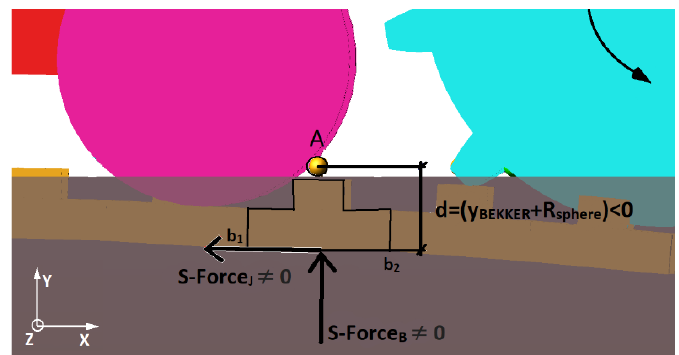
Figure 12. Forces acting on the single link.